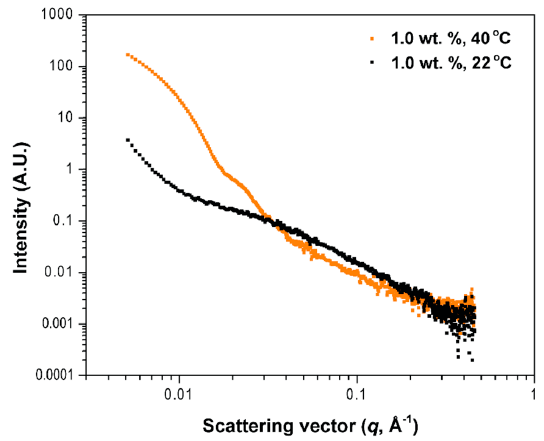
Figure 3. Small-angle X-ray scattering intensities as a function of the scattering vector at different temperatures (22 °C and 40 °C), 1.0 wt % polymer solution in PBS.